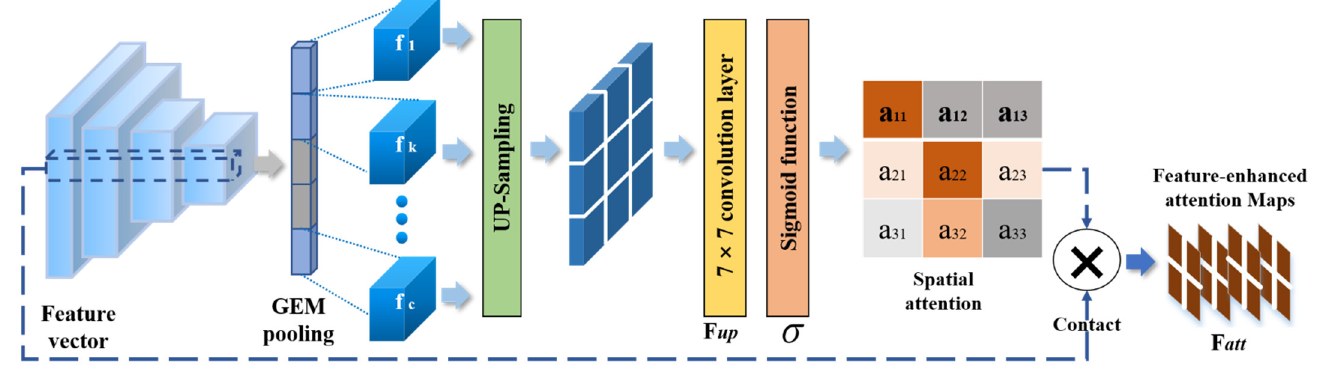
Figure 6. Module schematic of spatial feature ‐ enhanced attention.